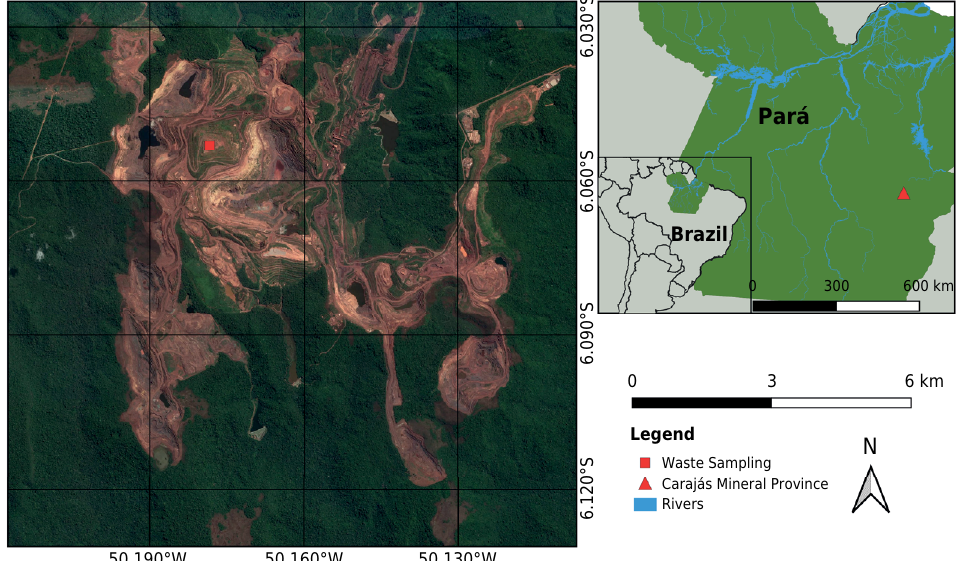
Figure 1. Location of the iron mine and waste sampling